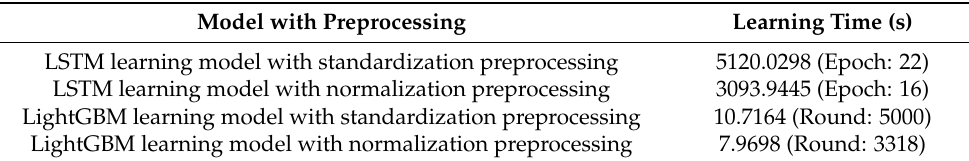
Table 6. Comparison of the learning time of different learning models.